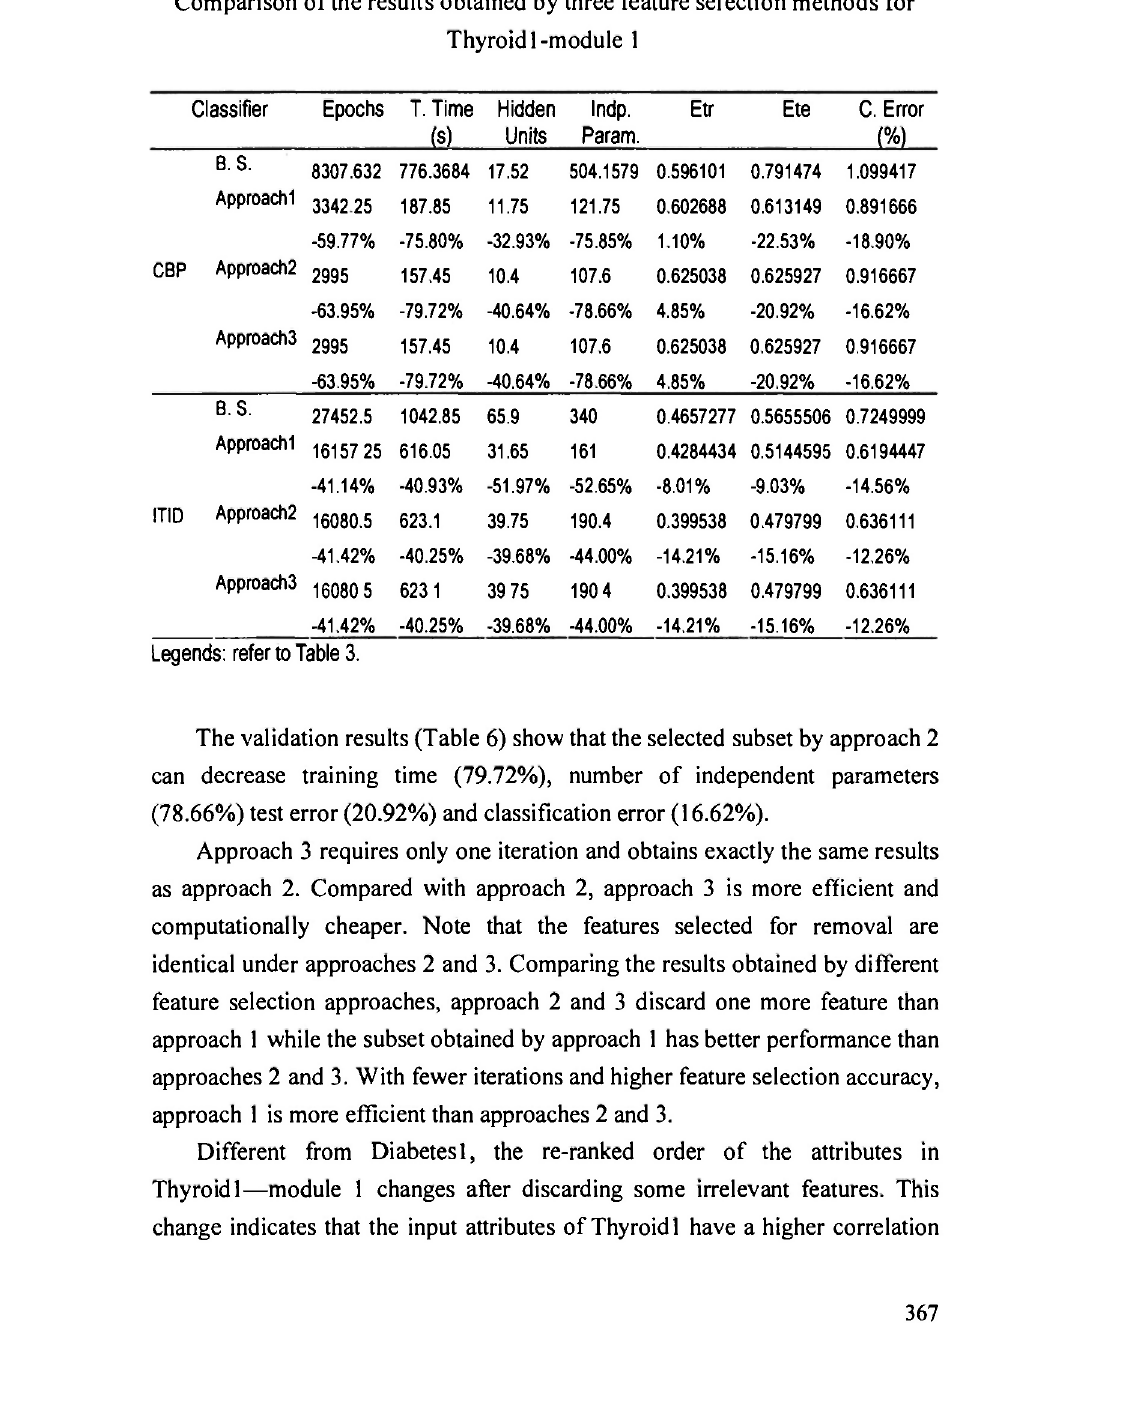
Comparison of the results obtained by three feature selection methods for Thyroid 1-module